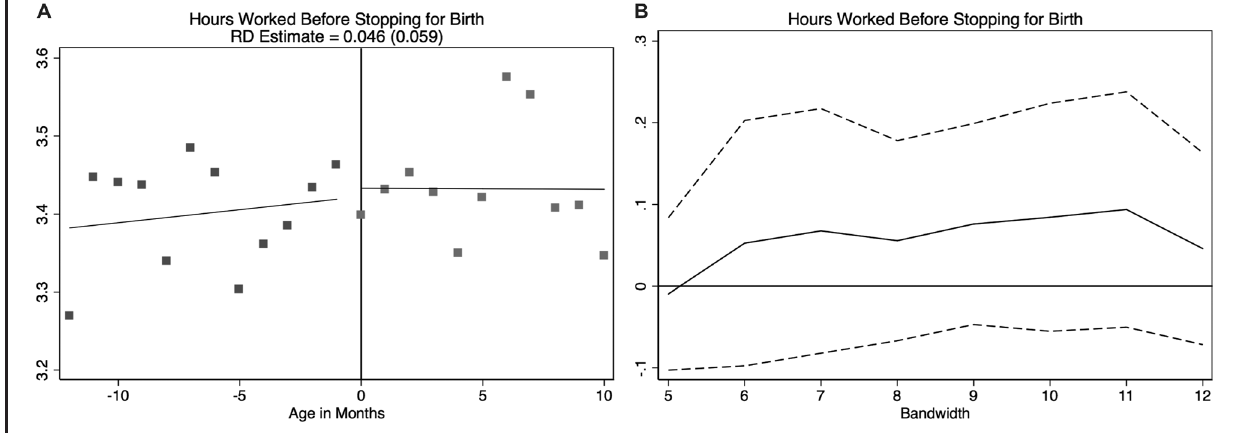
Figure 7 Average number of hours worked by the mother immediately before stopping work for the birth of her child. (A) Each data point corresponds to the average value of each outcome by month of birth of the child in 1-month bins. The window includes all children born to mothers from January 2010 until November 2011. The vertical line denotes the PPL cutoff of January 1 2011, normalized to 0. (B) The equivalent coefficient estimates and associated 95% confidence intervals when equation 1 is estimated using 3, 4, ..., 12 month-of-birth cohorts on either side of the threshold.